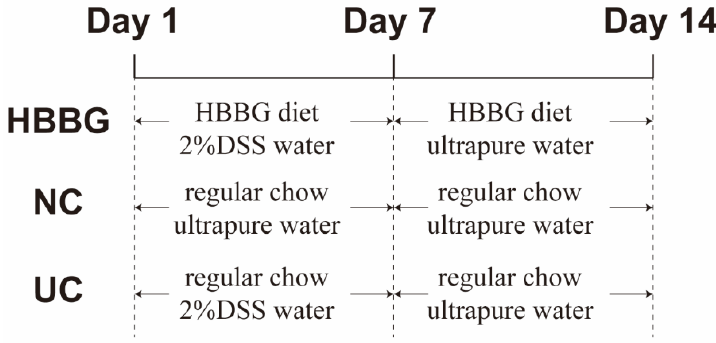
Figure 7. Diagrammatic representation of the 14 day experimental procedure.